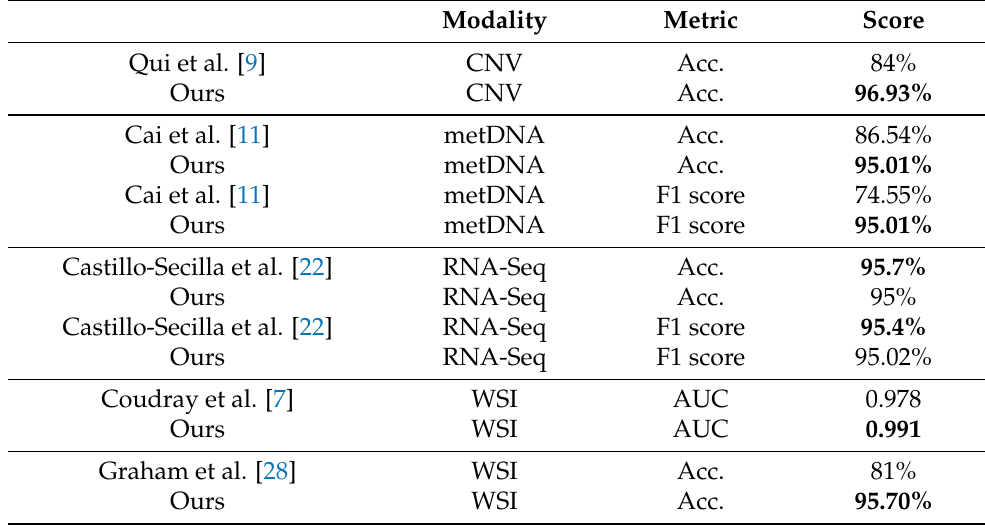
Table 6. Comparison of our fusion results with the available literature for LUAD vs. control vs. LUSC. The results of the fusion model are on those available samples for the studied modality. Unfortunately, a direct comparison of fusion methods cannot be performed given the lack of literature for this specific problem. The best results for each case are highlighted in